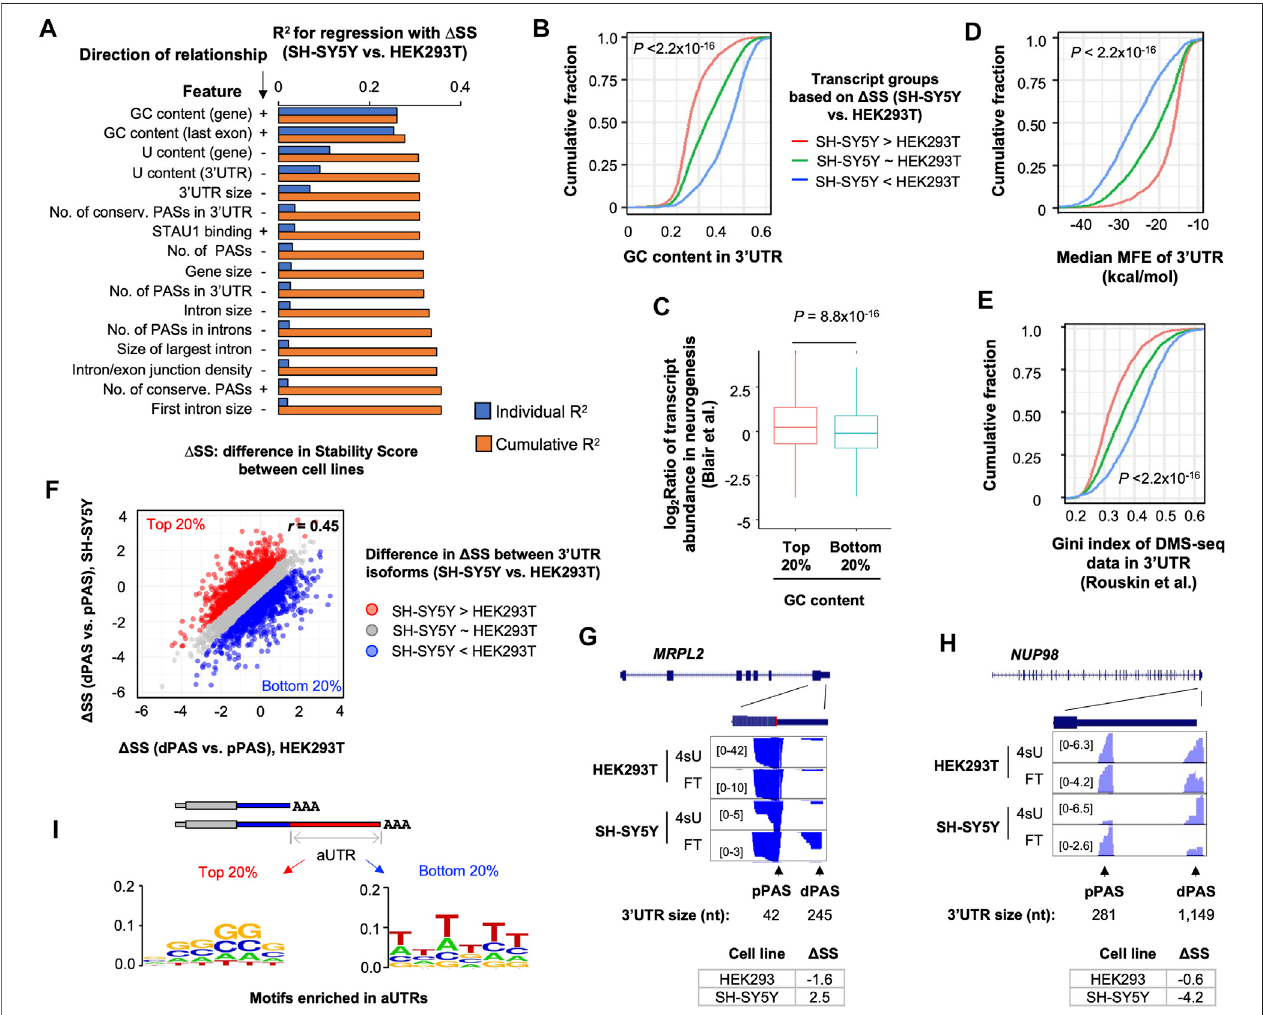
FIGURE 4 | GC content and RNA secondary structures contribute to distinct mRNA stability in SH-SY5Y cells. (A) Top features associated with Stability Score difference ( Δ SS) between SH-SY5Y cells and HEK293T, based on a linear regression analysis. Features are sorted according to individual R 2 values. The cumulative R 2 value is based on a given feature combined with all other features with a better individual R 2 value. Direction of relationship is indicated by + and – , denoting positive and negative correlations, respectively. (B) Cumulative distribution function (CDF) curves comparing 3 ′ UTR GC content of three transcript groups, based on Δ SS between SH-SY5Y and HEK293T cells. p -value (Wilcoxon test) indicating signi fi cance of differencebetween red and blue genesis indicated. (C) Boxplot showing gene expression regulation in neurogenesis (neurons vs. hESCs, Blair et al.) for genes with high (top 20%) or low (bottom 20%) 3 ′ UTR GC contents. (D) As in B, except that medianminimumfoldingenergy(MFE)of3 ′ UTRisplotted. (E) AsinB,exceptthatRNAstructureprobingdatafromDMS-Seqareshown.Giniindexre fl ectslikelihoodof RNA structures. (F) Scatter plot comparing Δ SS (dPAS isoform vs. pPAS isoform) between SH-SY5Y cells and HEK293T cells. Each dot is a gene with two selected 3 ′ UTR isoforms (dPAS and pPAS isoforms). The top 20%(red) and bottom 20% (blue) genes, 932each, based on Δ SS are highlighted in red and blue, respectively. (G) UCSC Genome Browser tracks of an example gene, MRPL2 , whose dPAS isoform is relatively more stable than pPAS isoform in SH-SY5Y cells as compared